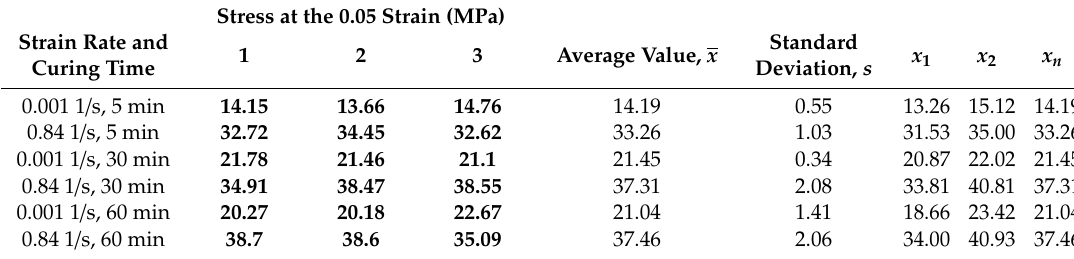
Table 2. Statistical analysis results for the static tests.